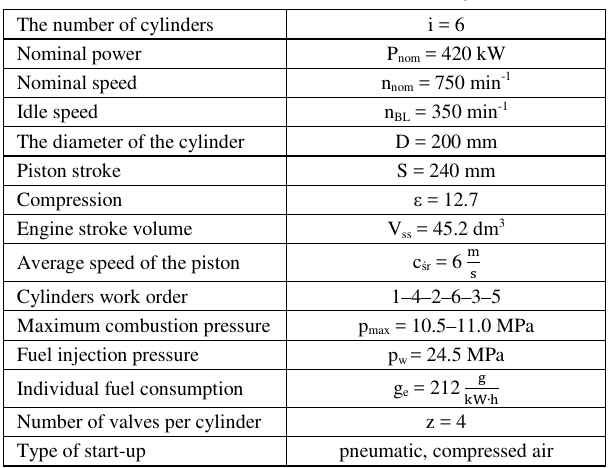
Table 2. Technical data of Sulzer 6AL20/24 engine [6]